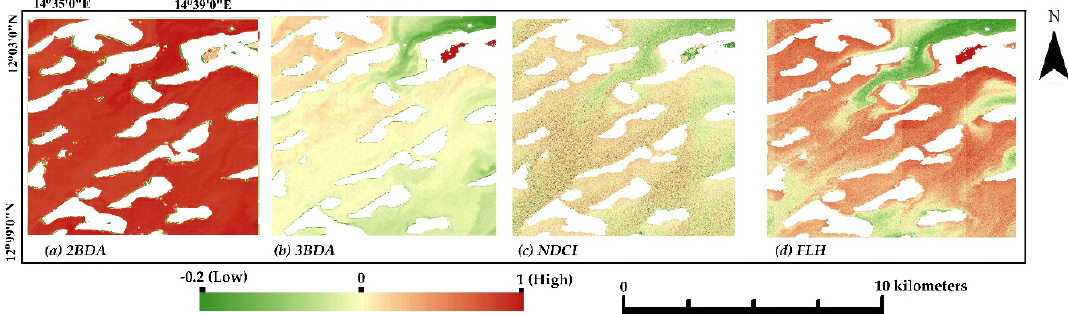
Figure 5. Chl a extraction from S2 image image. ( a – c ) index products were derived at 20-m spatial resolution while ( d ) was derived at 10-m spatial resolution. Increasing concentrations of Chl a are depicted by brighter pixels.